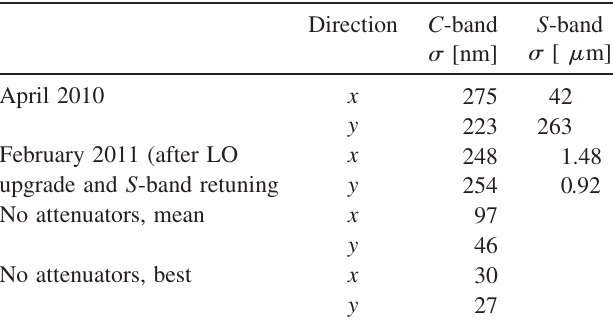
TABLE VI. Summary of BPMs